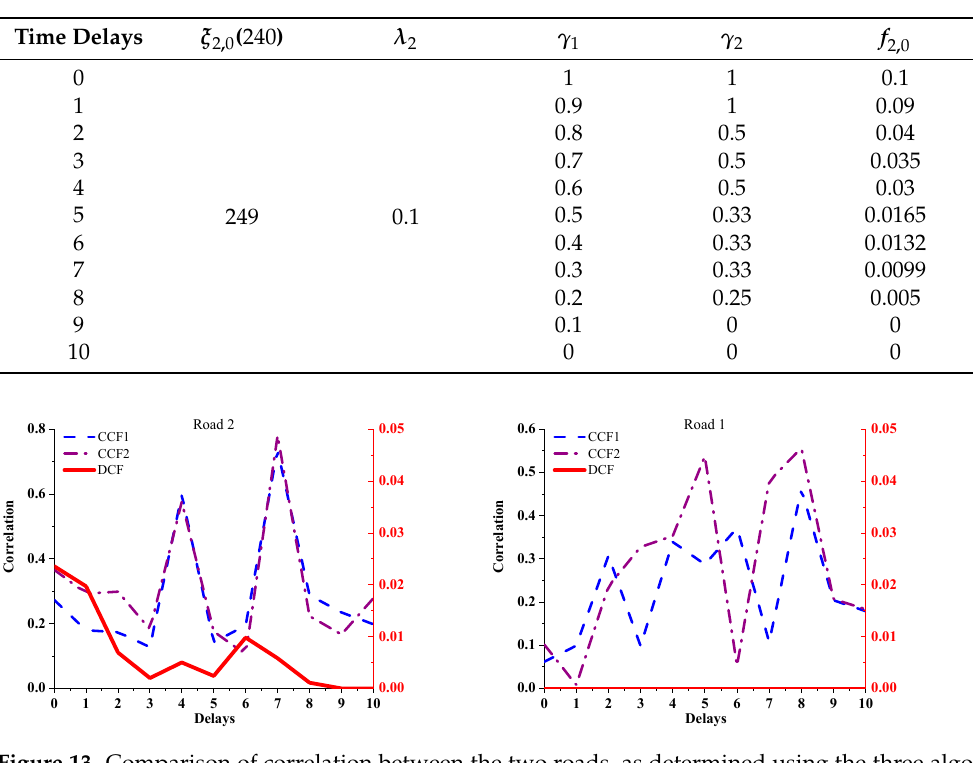
Figure 13. Comparison of correlation between the two roads, as determined using the three algorithms. Table 1. Flow ratio (%) of roads 2 and 1 to road 0.